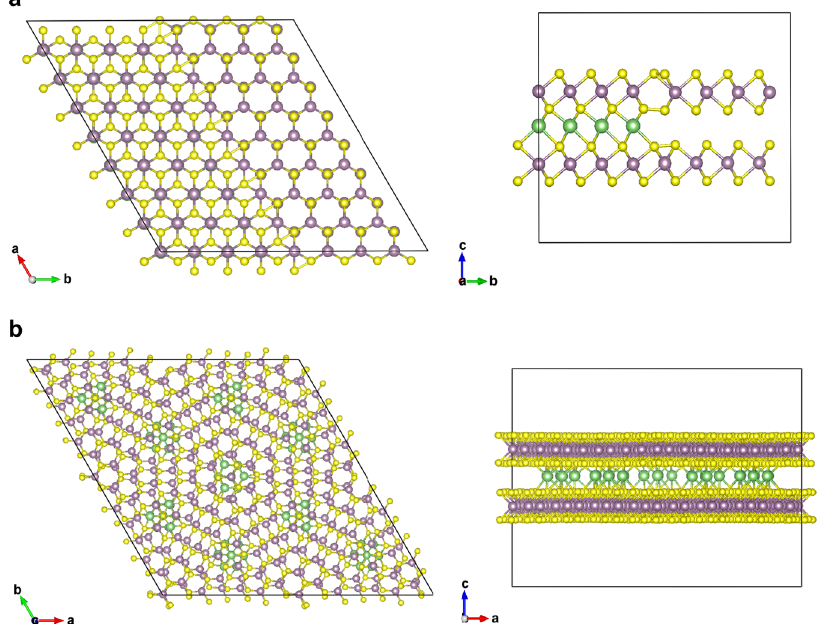
Fig. 1 Schematic illustration of lithium intercalation in MoS 2 . a Lithium intercalation in bilayer 2H-MoS 2 through the edge, resulting a phase separation (left side: top view (view along the c-axis), right side: cross-section view). b Lithium intercalation in twisted bilayer MoS 2 (left side: top view (view along the c-axis), right side: cross-section